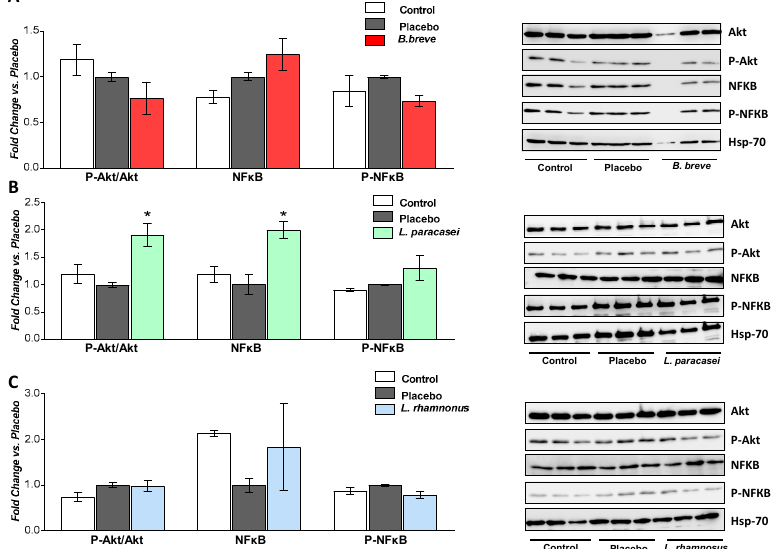
Figure 8. Western blot analysis of P-Akt/Akt ratio, NF- к B and P-NF- к B proteins of rats fed either placebo, ( A ) B. breve , ( B ) L. paracasei or ( C ) L. rhamnosus for 30 days. Hsp-70 was used as a loading control. Graphs on the left included 3 rats per group, and the right panels show representative blots. Values are the means ± SEM. * p < 0.05 vs. placebo. Akt, protein kinase B; B, Bifidobacterium ; Hsp70, 70 KD heat shock protein; L, Lactobacillus . NF- κ B, nuclear factor kappa-light-chain- enhancer of activated B cells; P-Akt, phosphorylated protein kinase B; P-NF-kB, phosphorylated nuclear factor kappa- light-chain-enhancer of activated B cells.